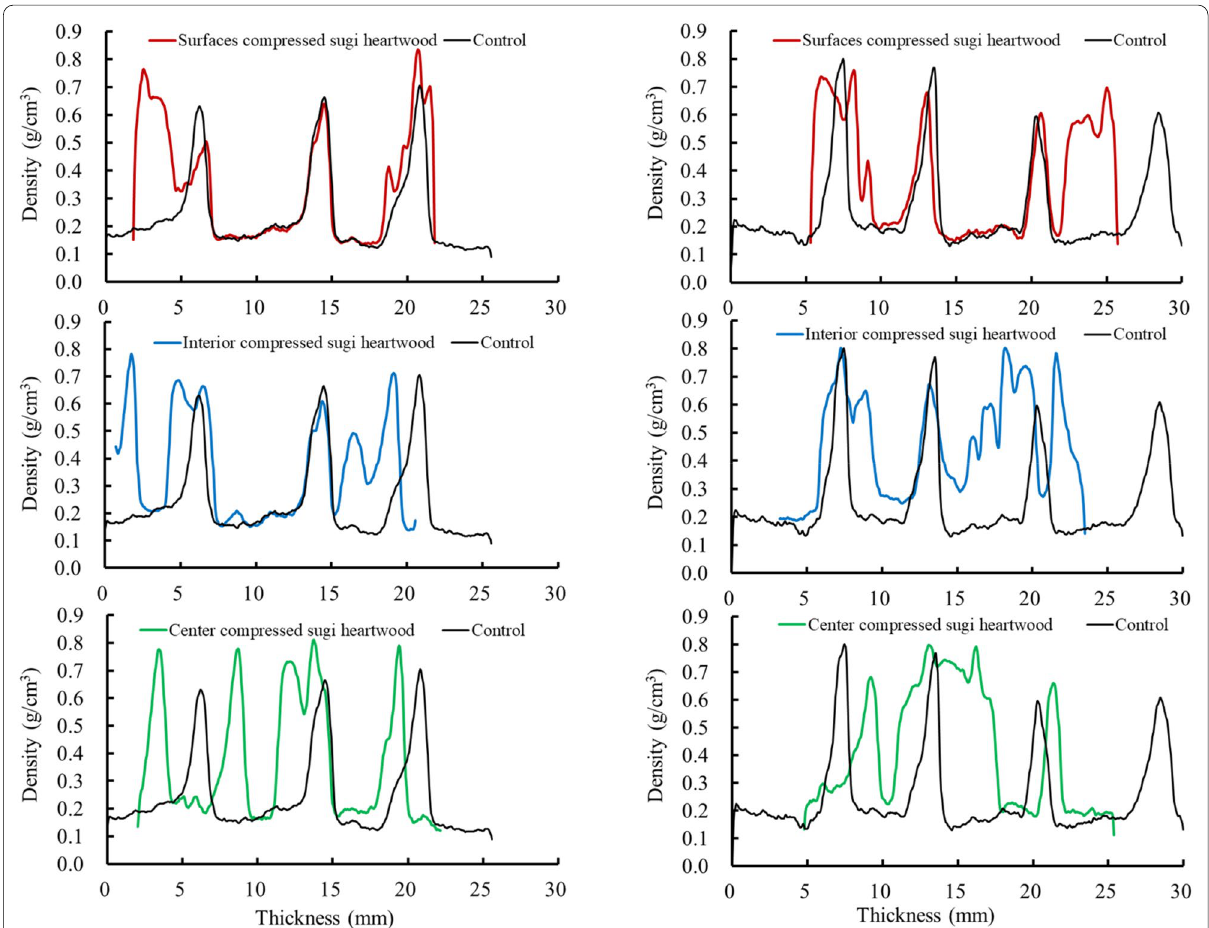
Fig. 3 Density distribution along the thickness of sandwich compressed sugi heartwood timber (left: compressed from 26 to 20 mm; right: compressed from 30 to 20